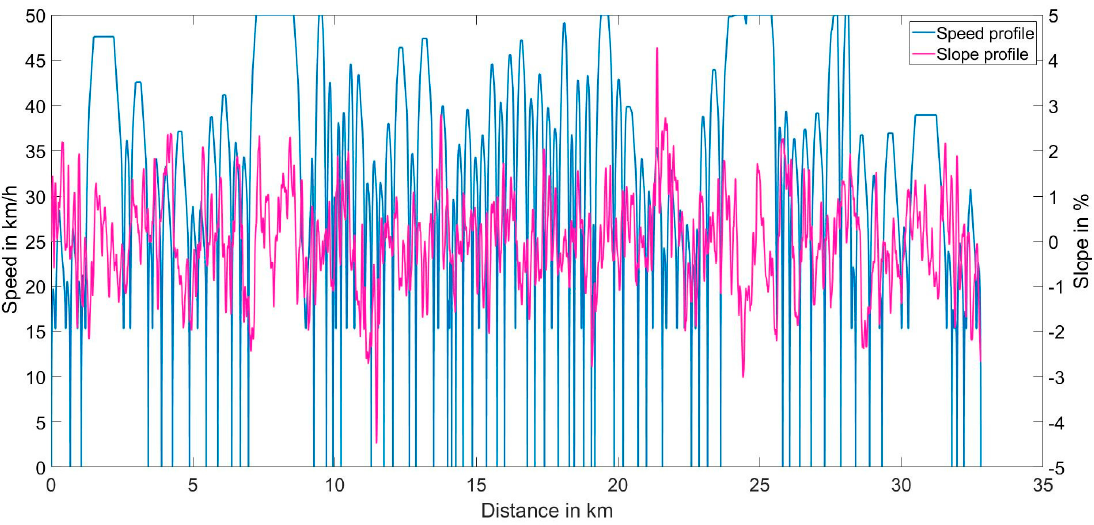
Figure 2. Derived speed and slope profiles.